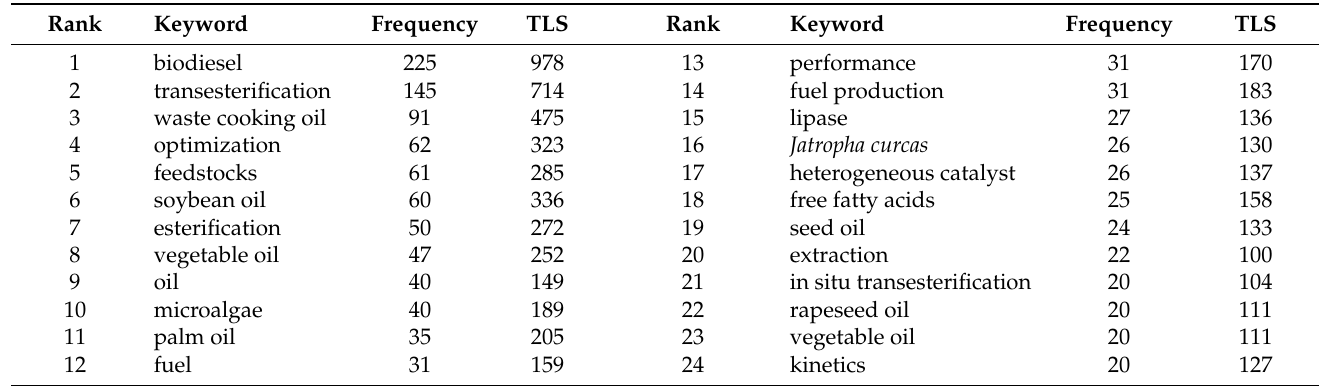
Table 4. Ranking of the 24 most prominent keywords mentioned in the analyzed articles.